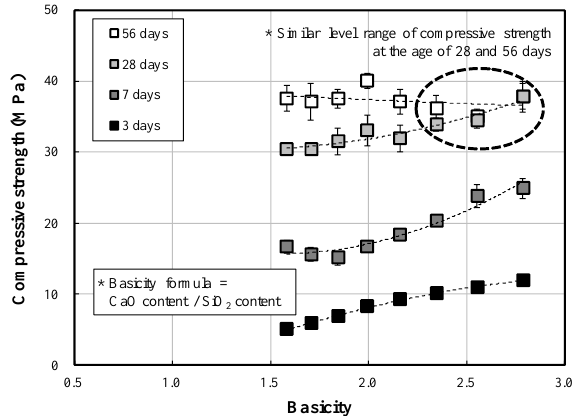
Appl. Sci. 2020 , 3 , x FOR PEER REVIEW Figure 11. Compressive strength with respect to basicity. Figure 11. Compressive strength with respect to basicity.